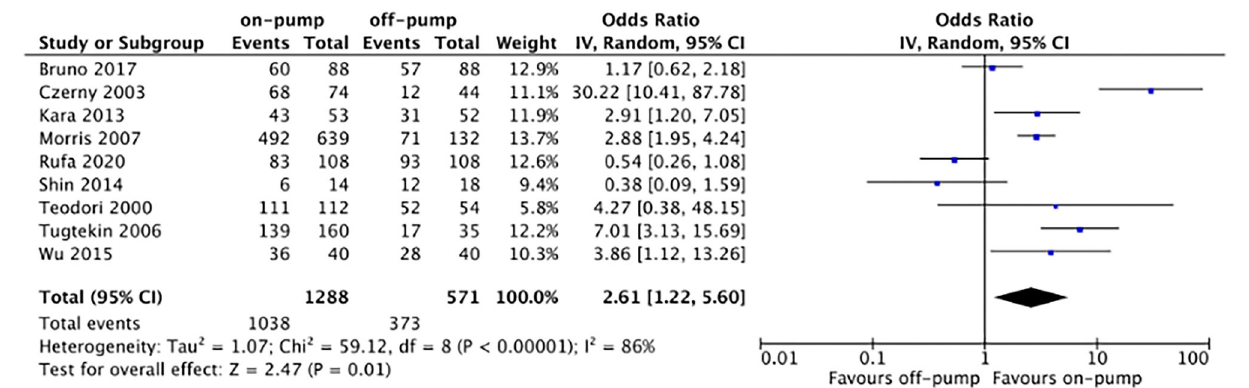
FIGURE 10 | Forest plot for total revascularization rate.